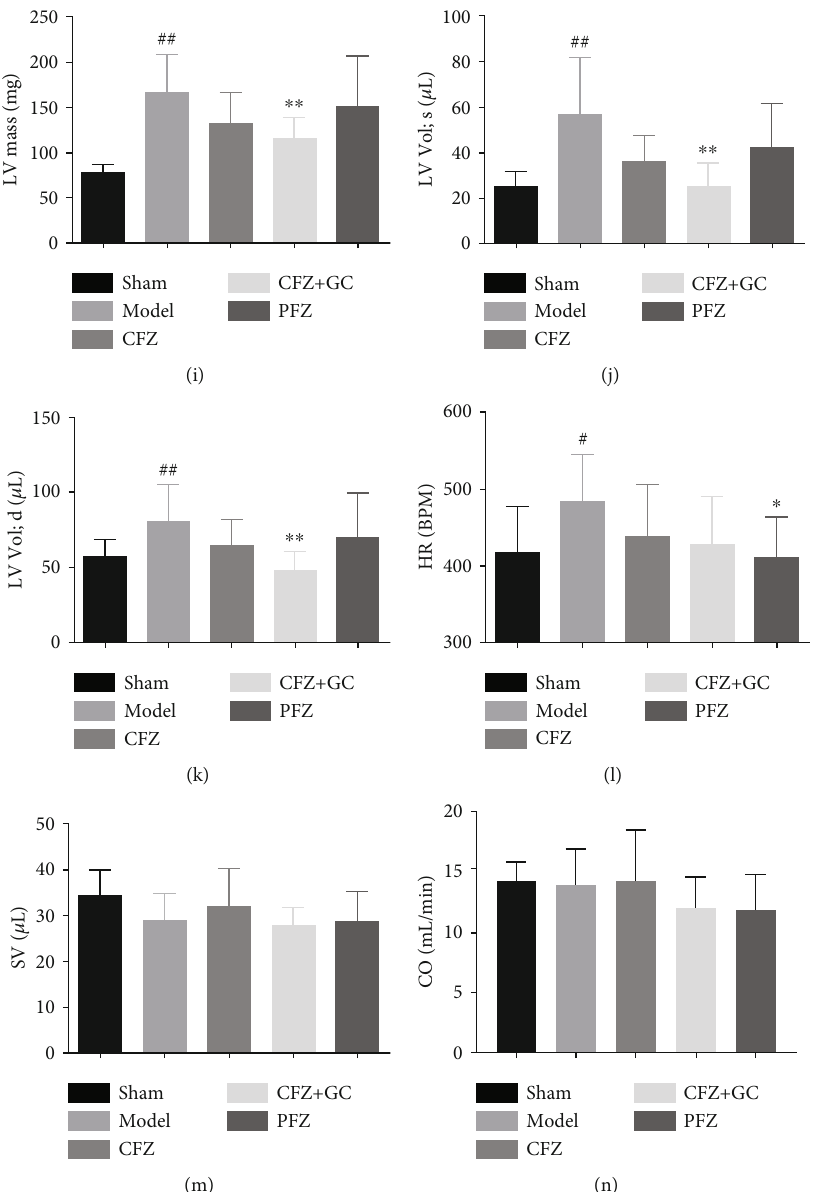
Figure 2: Hemodynamic indicators in mice of each group: (a) IVS; d: left ventricular end-diastolic anterior wall thickness; (b) IVS; s: left ventricular end-systolic anterior wall thickness; (c) LVID; d: left ventricular end-diastolic diameter; (d) LVID; s: left ventricular end- systolic diameter; (e) LVPW; d: left ventricular end-diastolic wall thickness; (f) LVPW; s: left ventricular end-systolic posterior wall thickness; (g) EF: ejection fraction; (h) LV mass corrected: left ventricular-corrected weight; (i) FS: fractional shortening; (j) HR: heart rate; (k) SV: stroke volume; (l) LV Vol; s: left ventricular end-systolic volume; (m) LV Vold; d: left ventricular end-diastolic volume; (n) CO: cardiac output. Sham group ( n = 7 ), model group ( n = 7 ), crude Fuzi (CFZ) group ( n = 5 ), CFZ combined with Glycyrrhiza (CFZ+GC) group ( n = 9 ), and prepared materials of Fuzi (PFZ) group ( n = 9 ). All data are presented as the mean ± SD . # P < 0 : 05 and ## P < 0 : 01 versus model group.; ∗ P < 0 : 05 and ∗∗ P < 0 : 01 versus model